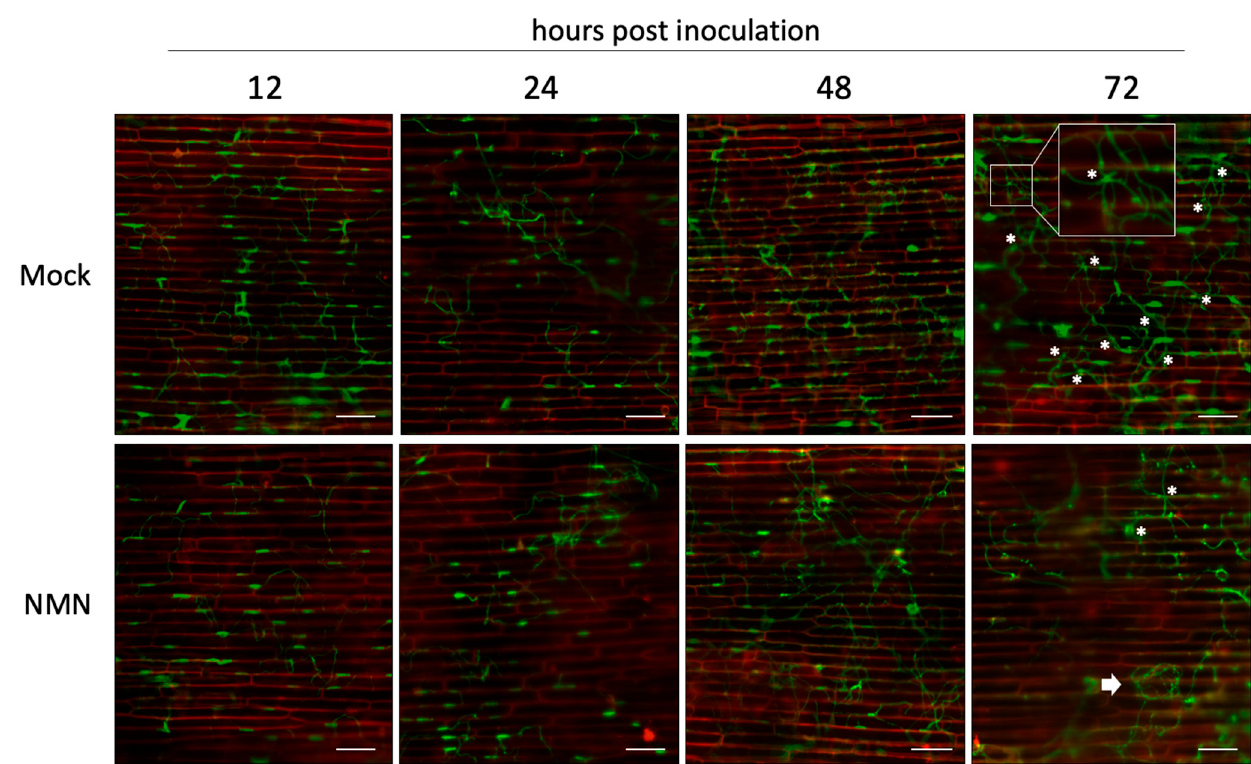
Figure 2. Infection behavior of Fusarium graminearum on coleoptile epidermal cells treated with NMN. The coleoptile epidermal cells were treated with 500 ppm NMN and inoculated with conidia of GFP-expressing F. graminearum . After inoculation, plasma membranes of epidermal cells were stained with FM4-64. The asterisks indicate hyphal entanglements. The square enclosure shows the magnified hyphal entanglement. The arrow indicates typical wandering hyphae with many turning points. Scale bars = 100 µm.